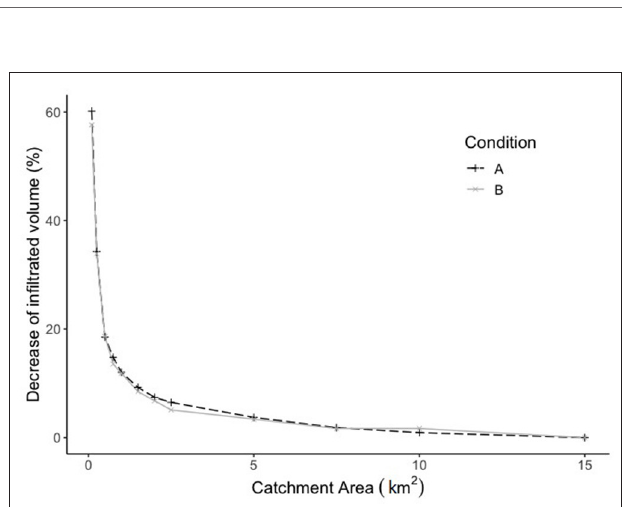
FIGURE 8 | Decrease of average yearly infiltrated water volume for different check dam catchment areas relative to that of a catchment area of 15 km 2